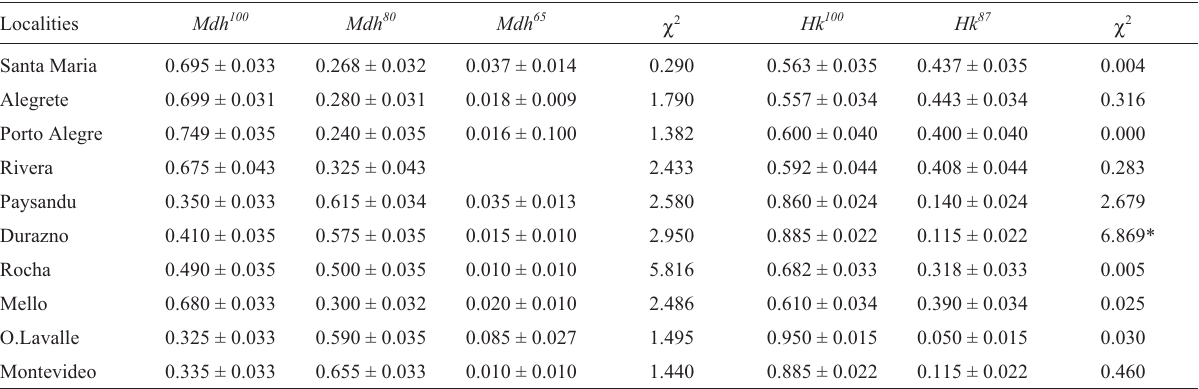
Table 2 - Allele frequencies and χ 2 values for genetic equilibrium tests at the Mdh-1 and Hk loci in Apis mellifera populations from southern Brazil and Uruguay. Localities